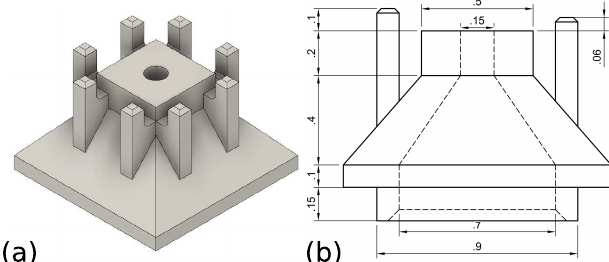
Figure 2. ( a ) Isometric view and ( b ) technical drawing of gripper head printed with Nanoscribe [13] (dimensions in